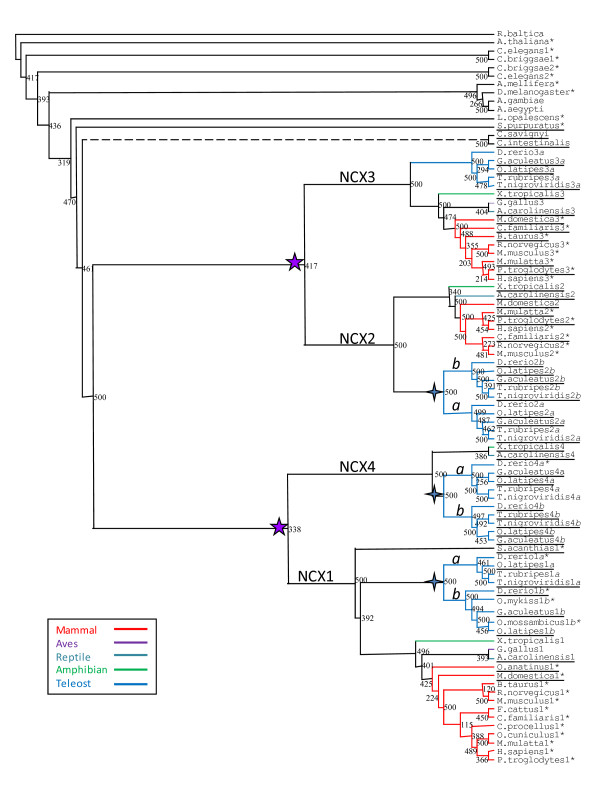
Maximum Likelihood NCX Phylogenetic Tree. The ML phylogenetic tree was generated with the PHYML program with 500 replicates using all known and postulated NCX protein sequences. Pirellula bacterial strain (Rhodopirellula baltica) was used to root this tree. The five-point stars () indicate NCX duplication after Ciona intestinalis divergence and the four-point stars () indicate teleost-specific NCX duplication. Branches are colour coded for vertebrate species, in which red designates mammals, purple indicates birds/aves, teal branches are for reptiles, green are amphibians, and blue are teleosts/fish. The dashed branch (---) indicates the division between invertebrate and vertebrate NCX sequences. The asterisk (*) indicates complete transcripts and those without an asterisk are genomic sequences. The letters 'a' and 'b' correspond to the teleost duplicate versions of NCX1, NCX2 and NCX4. Underlined species are new NCX sequences added in comparison to a previous paper [20].